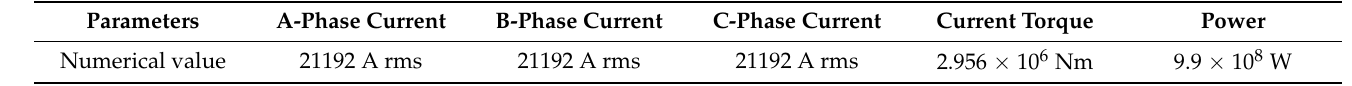
Table 4. Known value under 80% load of